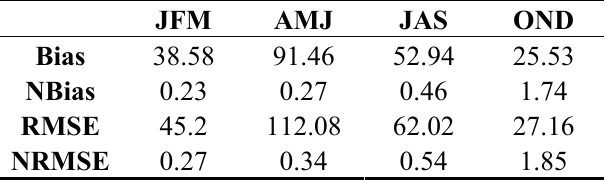
Table 6. Errors estimators used in the validation dataset for each